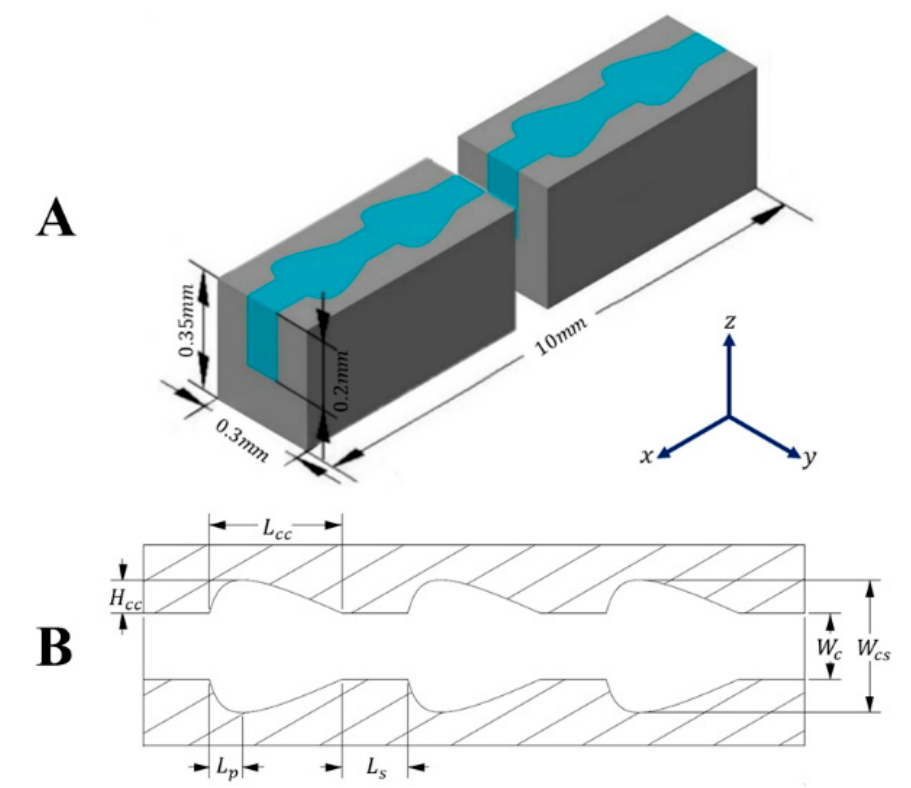
Figure 1. The MCHS with conical-shaped reentrant cavities ( A ) computational domain of the mi- crochannel and ( B ) the geometrical parameters of the new microchannel.